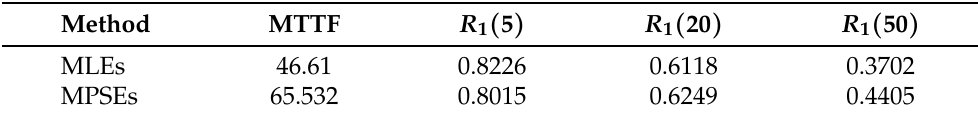
Table 11. The MLEs and MPSEs of the MTTF and RF for the breakdown of steel Type-II censored CSPALT